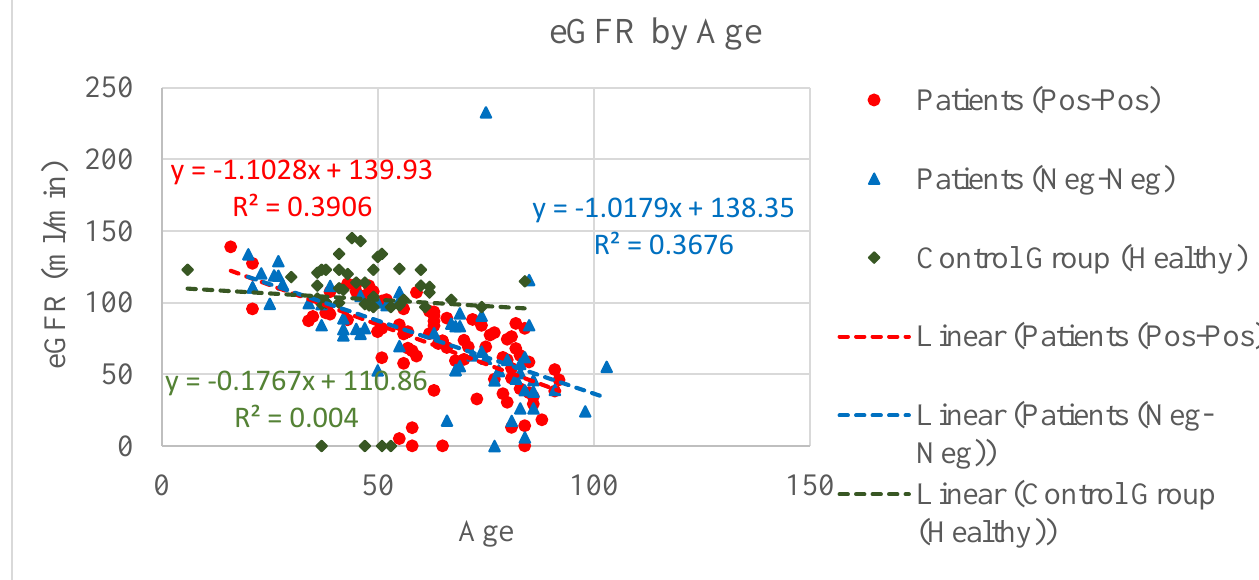
Figure 3. Scatter charts and regression lines for eGFR by age for COVID-positive (PP), COVID-free patients (NNp), and the healthy (NNh) group. The dotted eGFR axis shows more details for the medium area of eGFR concentration. This figure explicitly shows a significant decline of the eGFR level for COVID-positive and COVID-free NNp patients but no decline of the GFR level in the control group NNh. Nevertheless, the decline in the PP group is slightly higher than that of the NNp group.